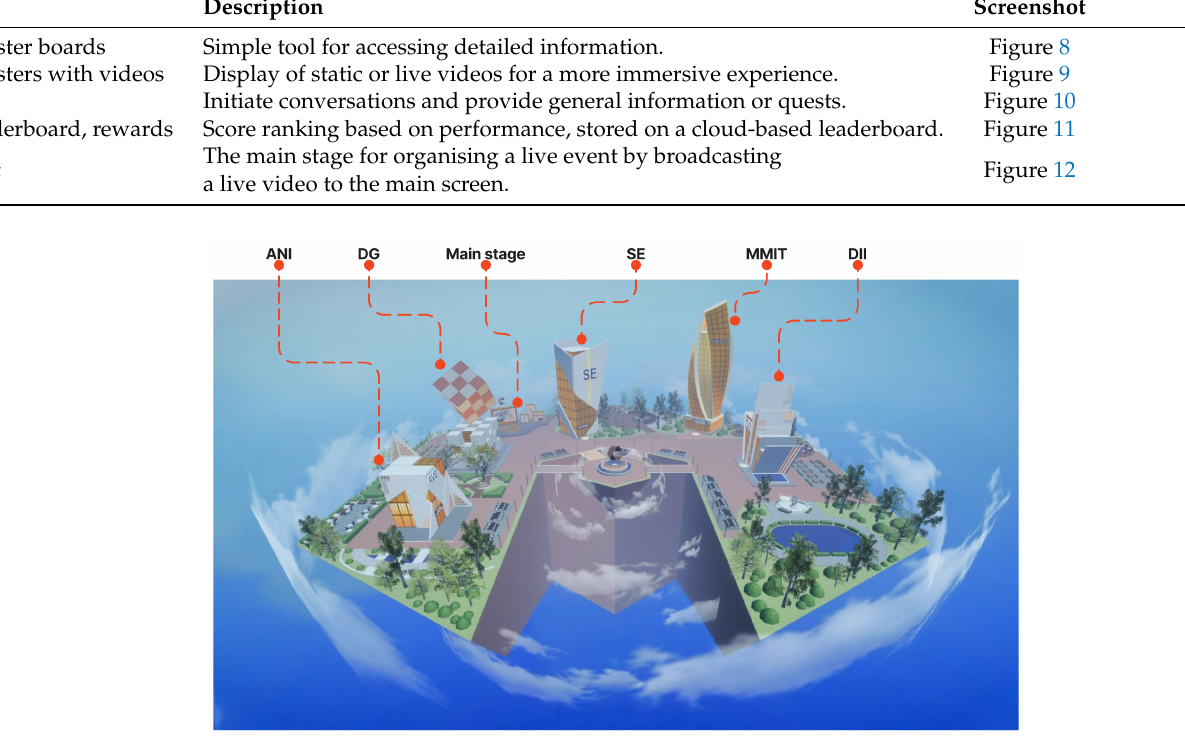
Figure 5. The design of the virtual world as a floating island surrounded by clouds. The island consists of five curriculum buildings and common areas with some atmospheric environment.